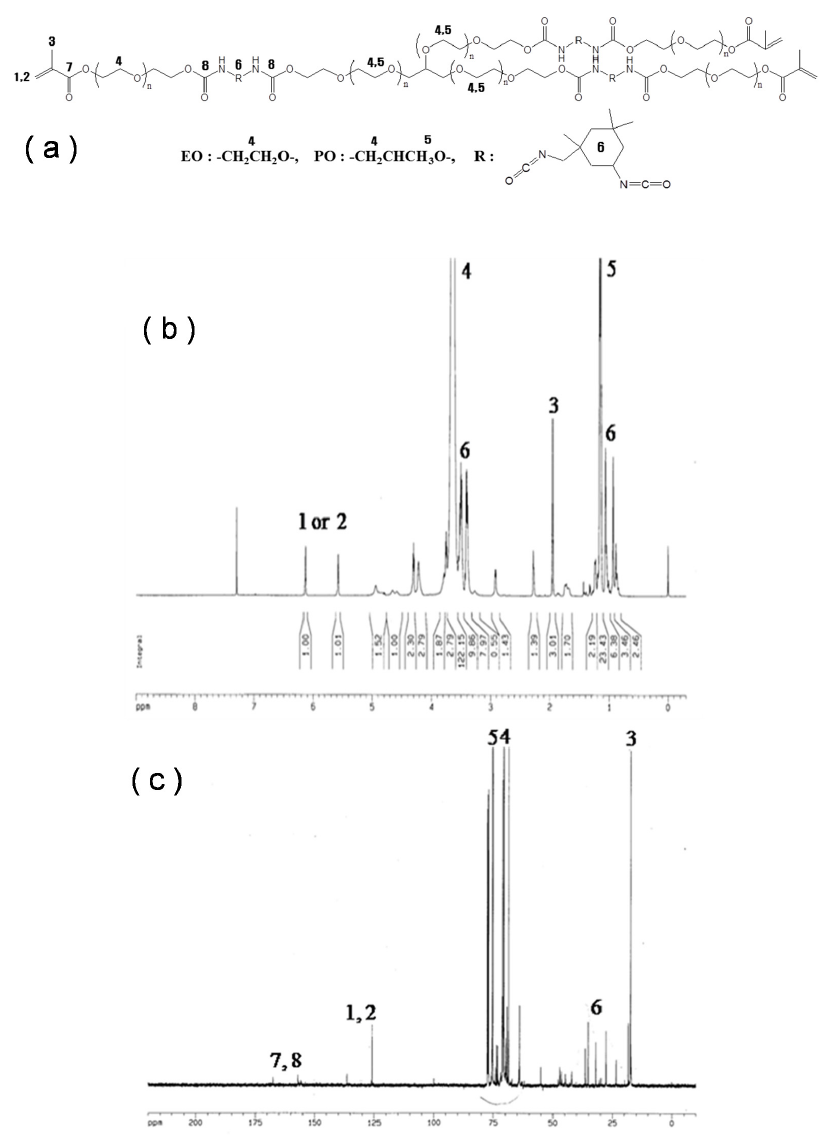
Figure 3. ( a ) Structure of oligomer and its spectra of ( b ) H-NMR and ( c ) C-NMR.